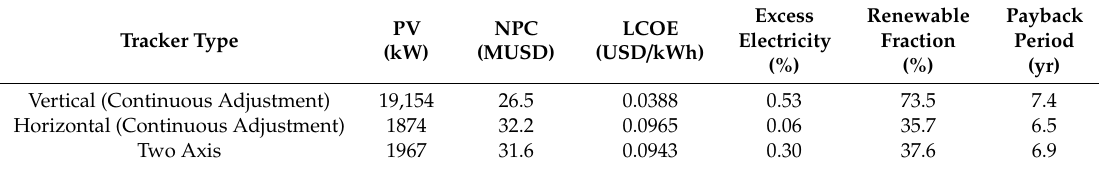
Table 2. Results of using different solar trackers on system performance and economic factors.